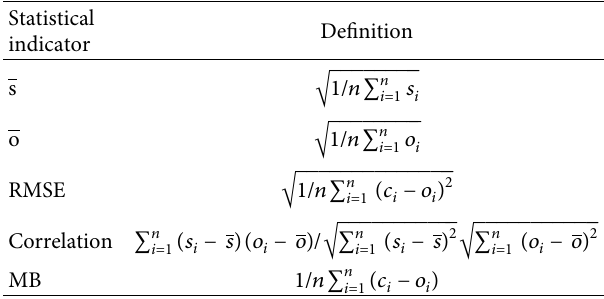
Table 6: Definition of the statistics used in this work. o the observed and simulated wind speeds at time i . n is the number of